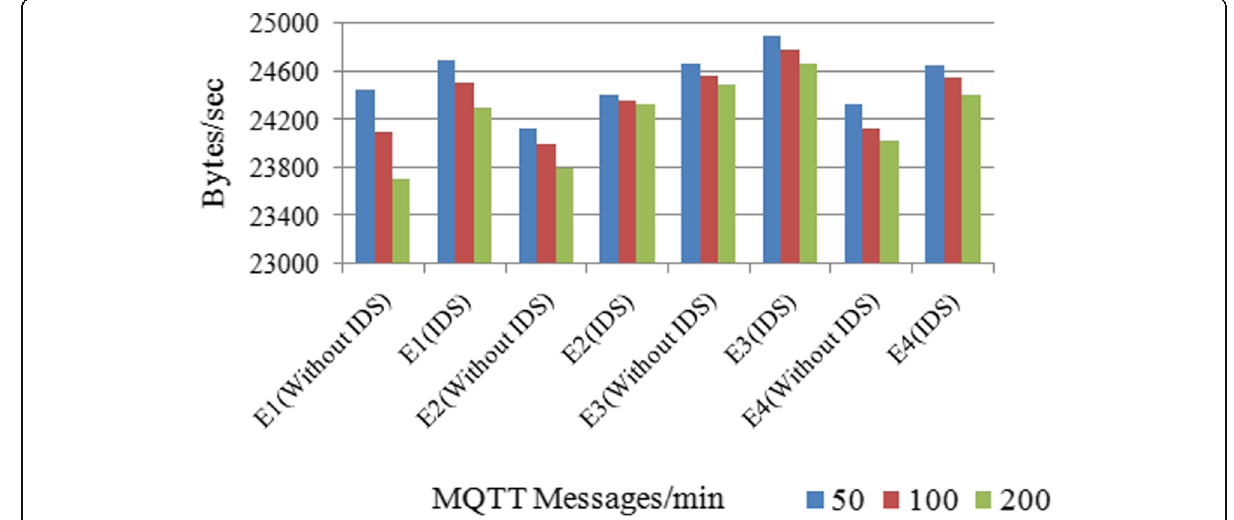
Fig. 13 Communication rate in